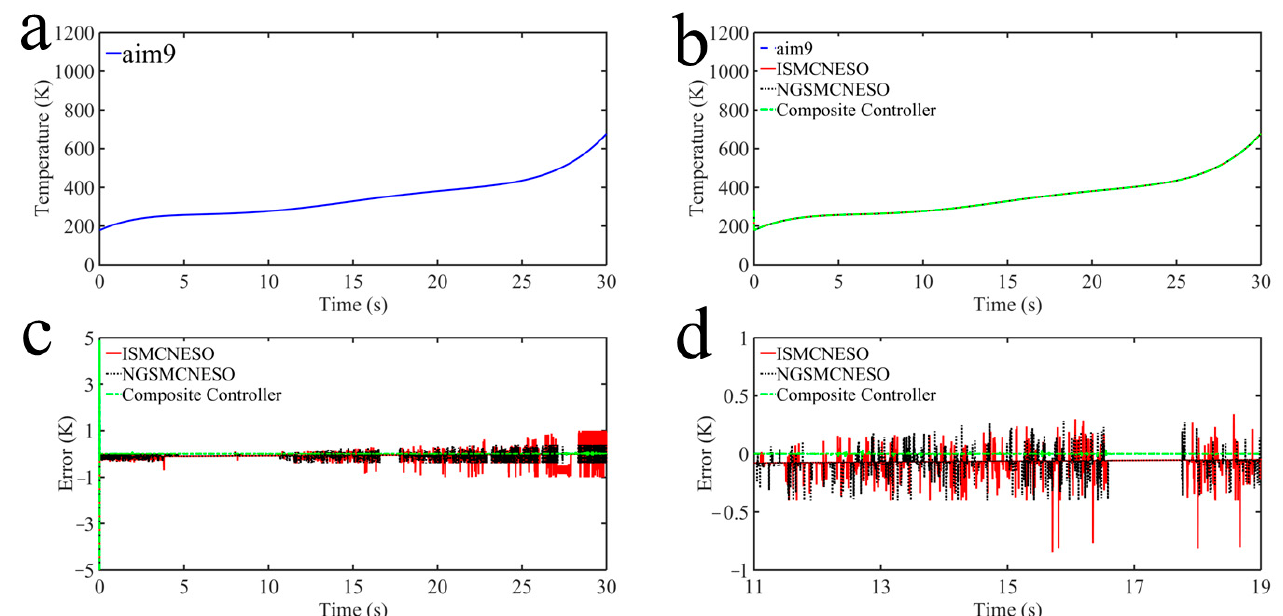
Figure 22. Simulation results: ( a ) the fitting curve of the reference temperature trajectory from Wall 2_85 mm; ( b ) the reference temperature tracking performance among ISMCNESO controller, NGSMCNESO controller, composite controller; ( c ) the tracking errors; ( d ) their partial enlarged figures in details.